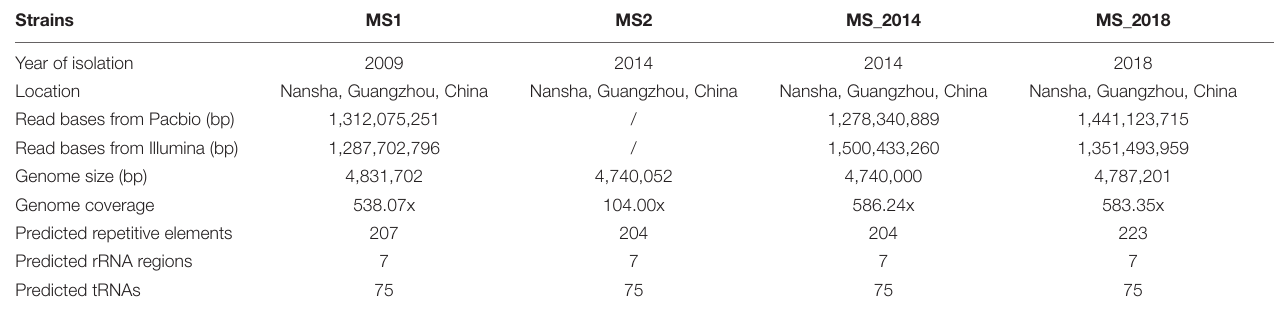
TABLE 2 | General genomic information for D . zeae strains isolated from